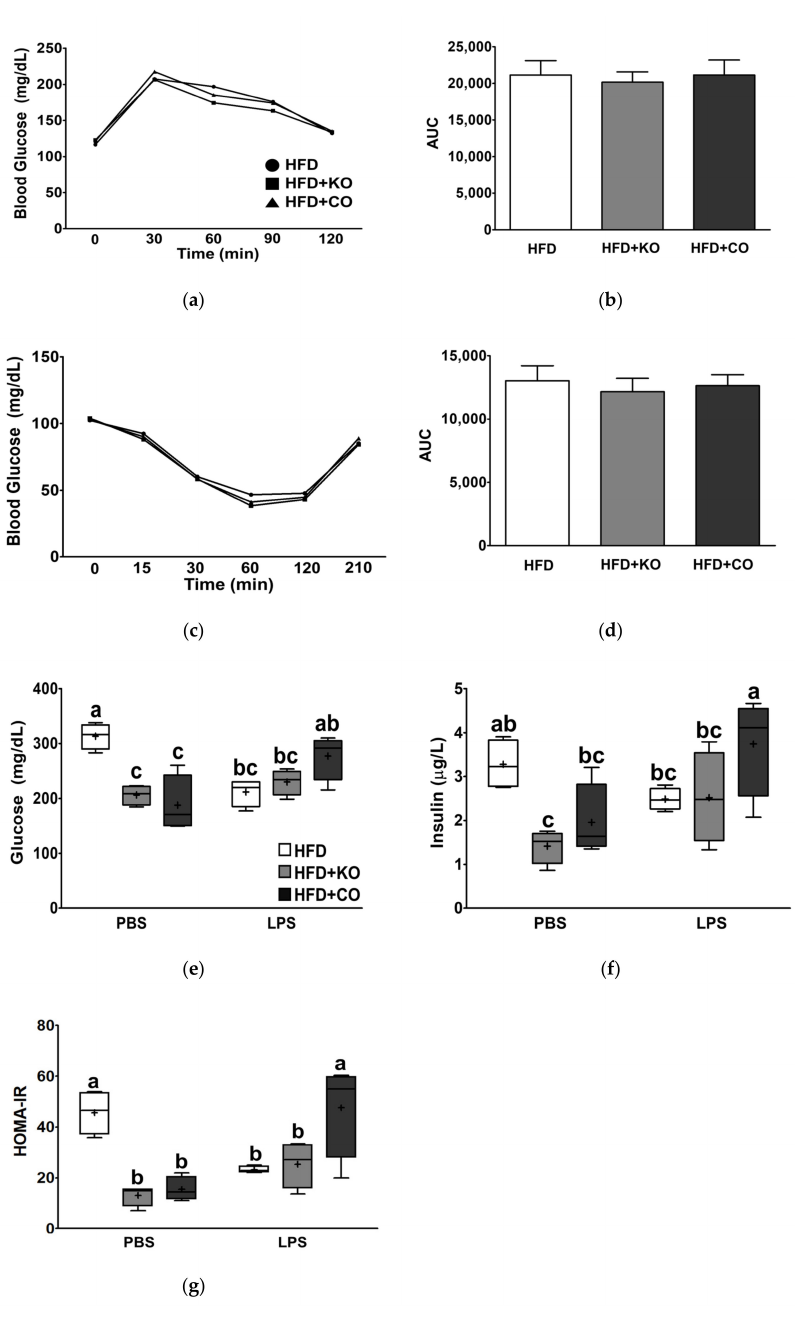
Figure 4. Effects of partial replacement of dietary fat with krill oil or coconut oil on glucose metabolism in rats. Sprague Dawley rats were fed either a high-fat diet (HFD), HFD partially replaced with